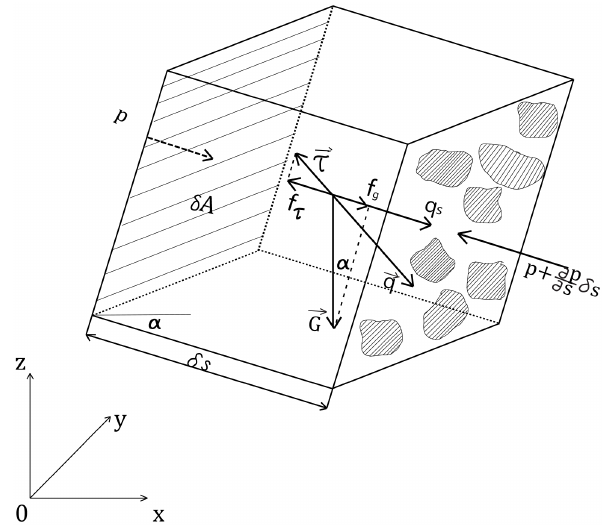
Figure 2. Definition sketch of liquid driving and opposed viscous forces for elemental